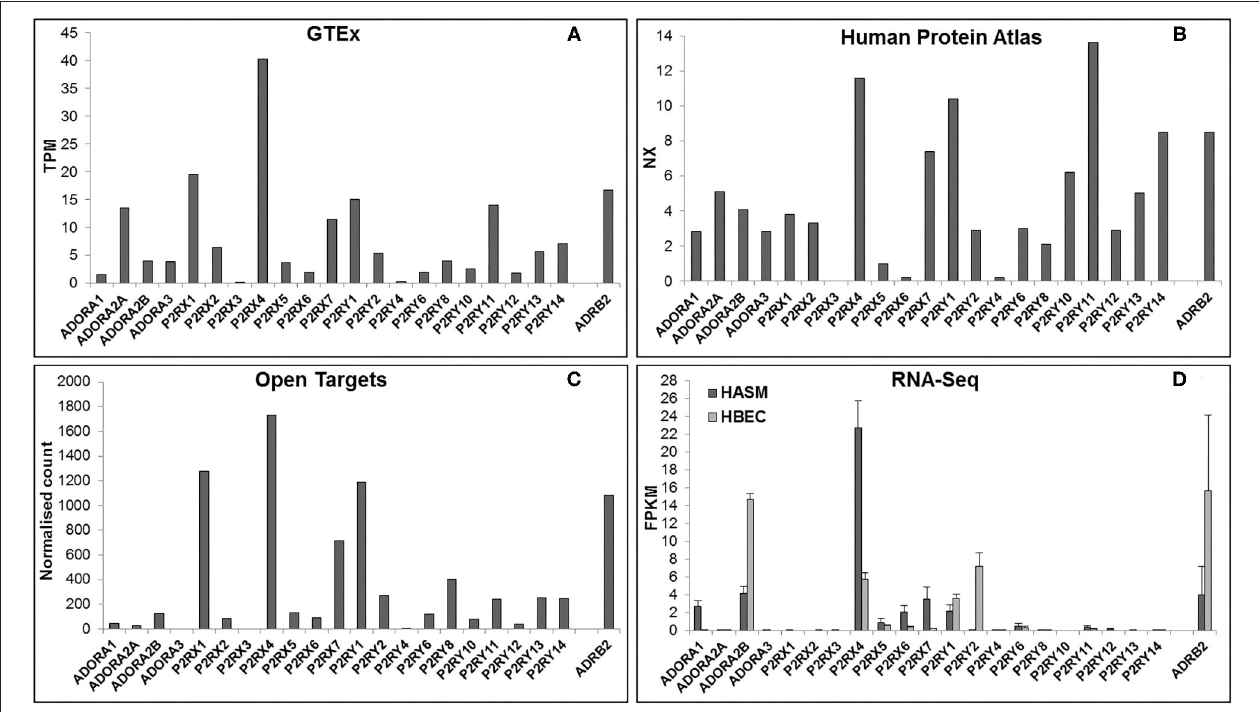
FIGURE 2 | Purinergic receptor RNA expression in lung and airway tissue from multiple online bioinformatics resources and novel RNA-Seq data. As a reference, expression data are also provided for the beta-2 adrenergic receptor (ADRB2), a GPCR that is currently a target for the treatment of respiratory disease. RNA expression data for each gene in lung tissue were gathered from three online resources: (A) GTEx Portal {data are median transcripts per million (TPM), n = 578 [www.gtexportal.org (v7) (23), date first accessed: 01/04/2020]}, (B) Human Protein Atlas {data are consensus normalized expression (NX), n = 438 [http://www. proteinatlas.org (v19.3) ( 24, 25), date first accessed: 06/04/2020]}, and (C) Open Targets Platform {data are normalized counts, n = 374 [www.targetvalidation.org (v3.18.0) (26), date first accessed: 13/04/2020]}. (D) RNA expression data for each purinergic receptor were also gathered from RNA-Seq data on two primary cell types from lung and airway tissue: human airway smooth muscle (HASM; dark gray bars) and human bronchial epithelial cells (HBEC; light gray bars). RNA-Seq data are mean ± SEM fragments per kilobase per million mapped reads (FPKM); n = 5 HASM donors and n = 8 HBEC donors